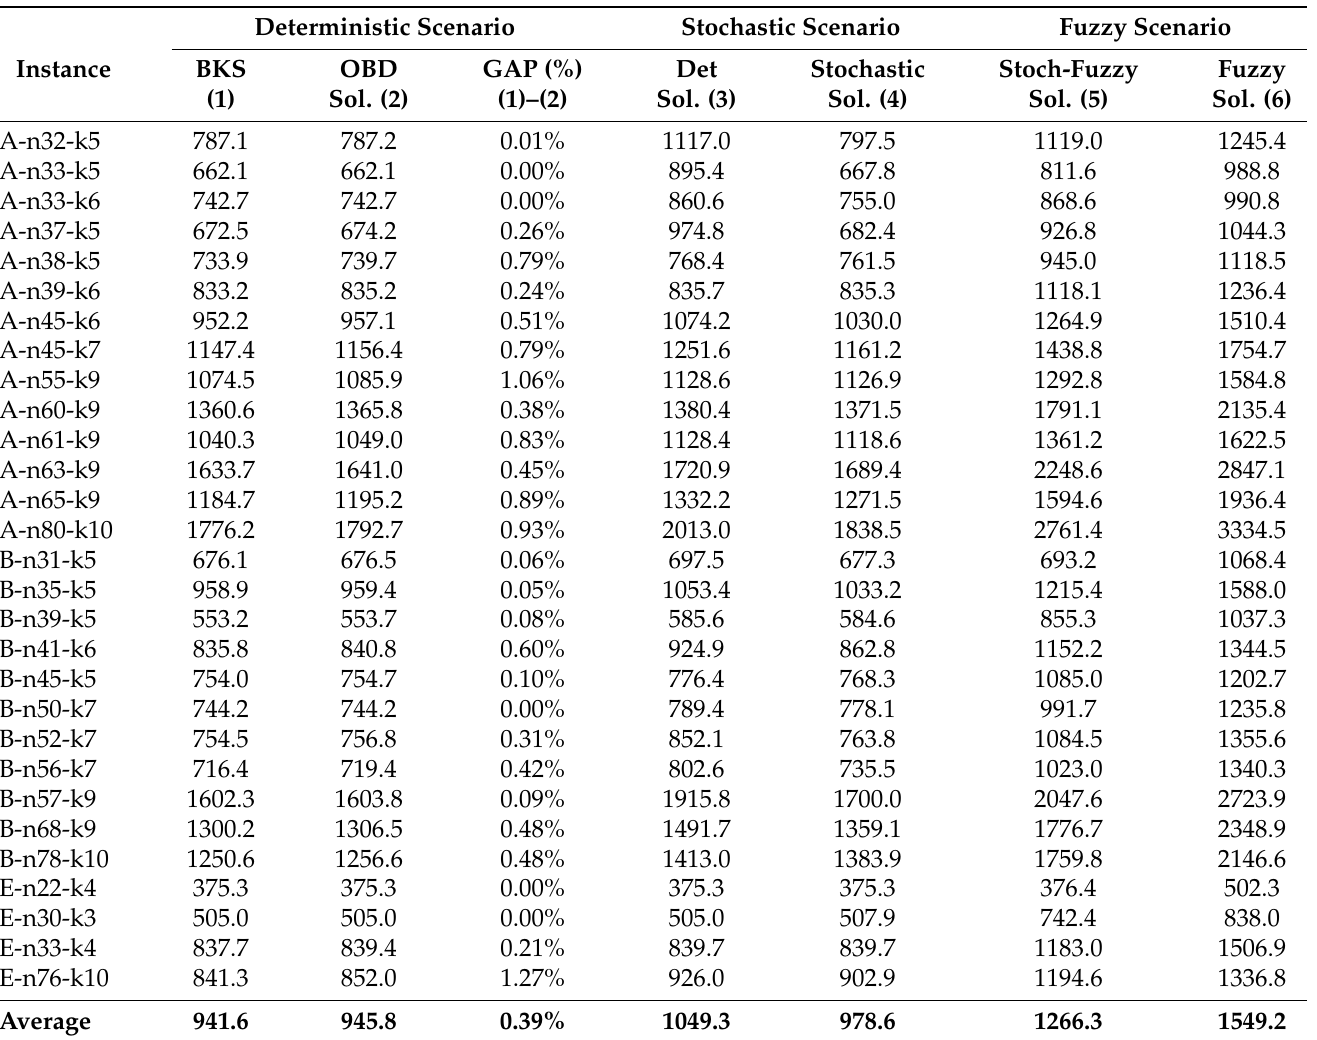
Table 3. Comparison of results, in terms of traveled distance, for the different VRP